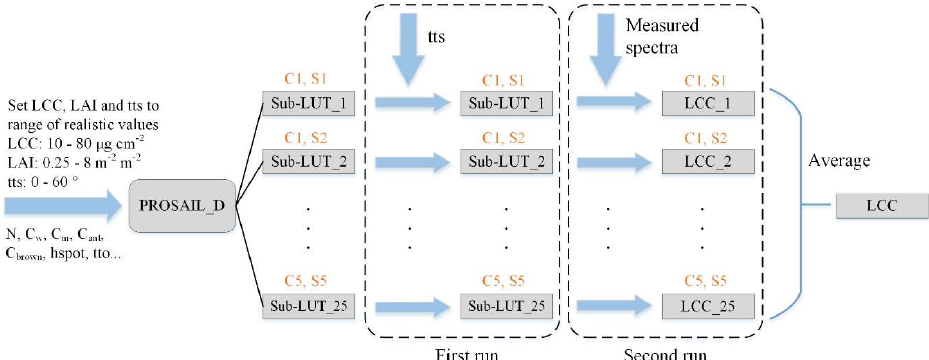
Figure 5. Flowchart of the algorithm used for LCC retrieval. C1 to C5 represent the canopy structures planophile, plagiophile, extremophile, spherical and uniform, respectively. S1–S5 represent the soil